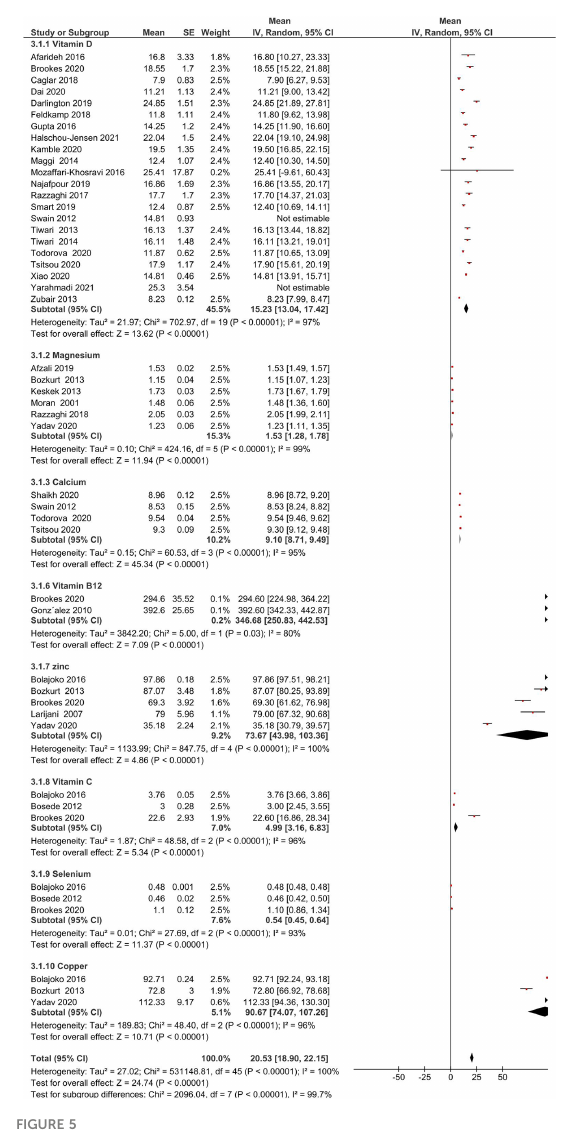
FIGURE 5 Forest plot for the sensitivity analysis. Sensitivity analysis was performed by eliminating results of two studies with the lowest risk assessment